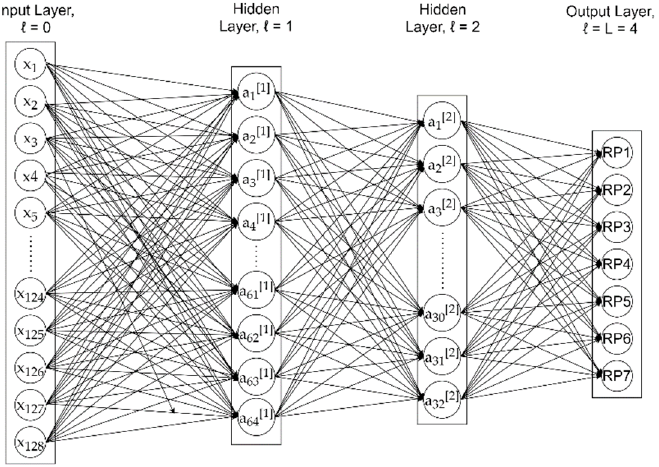
Figure 1. Architecture of our DNN model with two hidden layers.